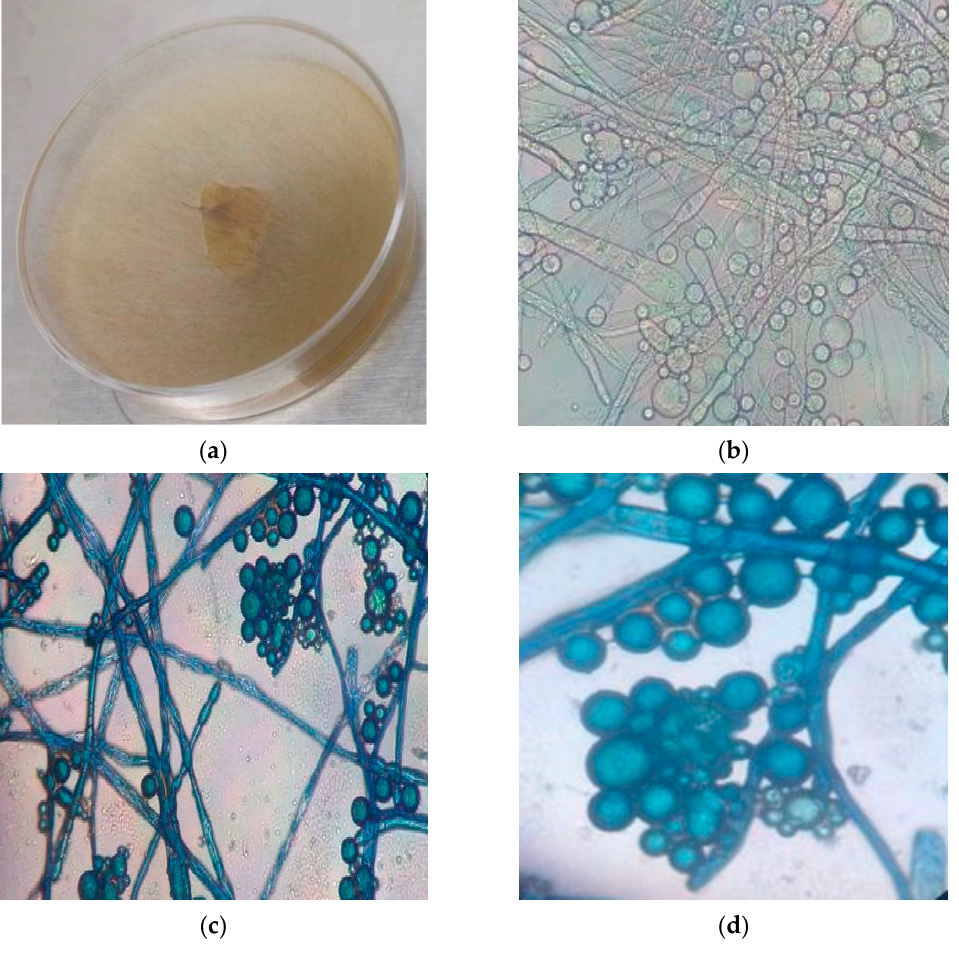
Figure 1. Morphological characteristic of M. circinelloides (C1502). ( a ) Macroscopic characteris- tics, ( b ) microscopic characteristics at 40 × , ( c , d ) lactophenol cotton blue-dyed samples at 40 × and 100 × ,